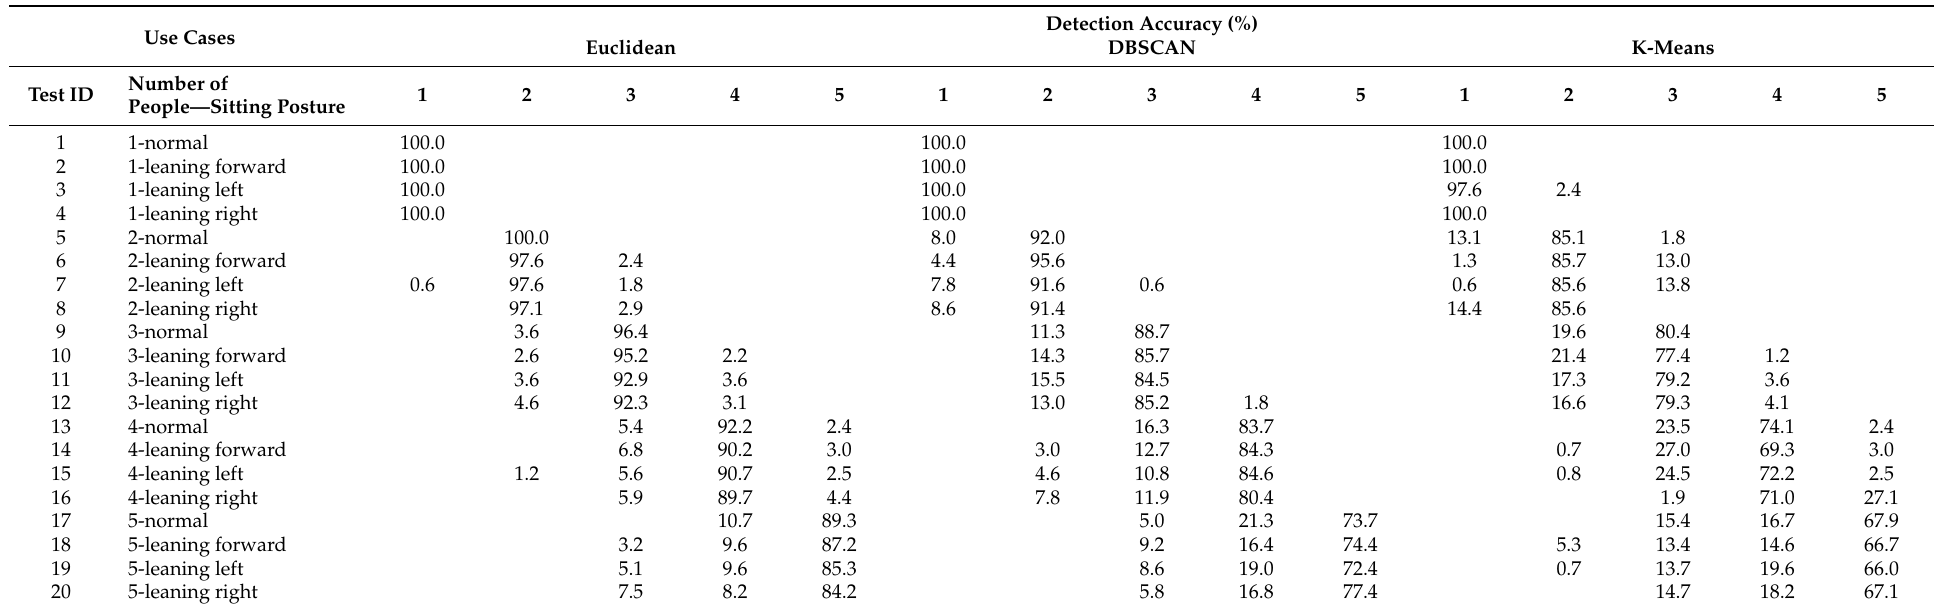
Table 3. Presentation detection results of different clustering methods in static use